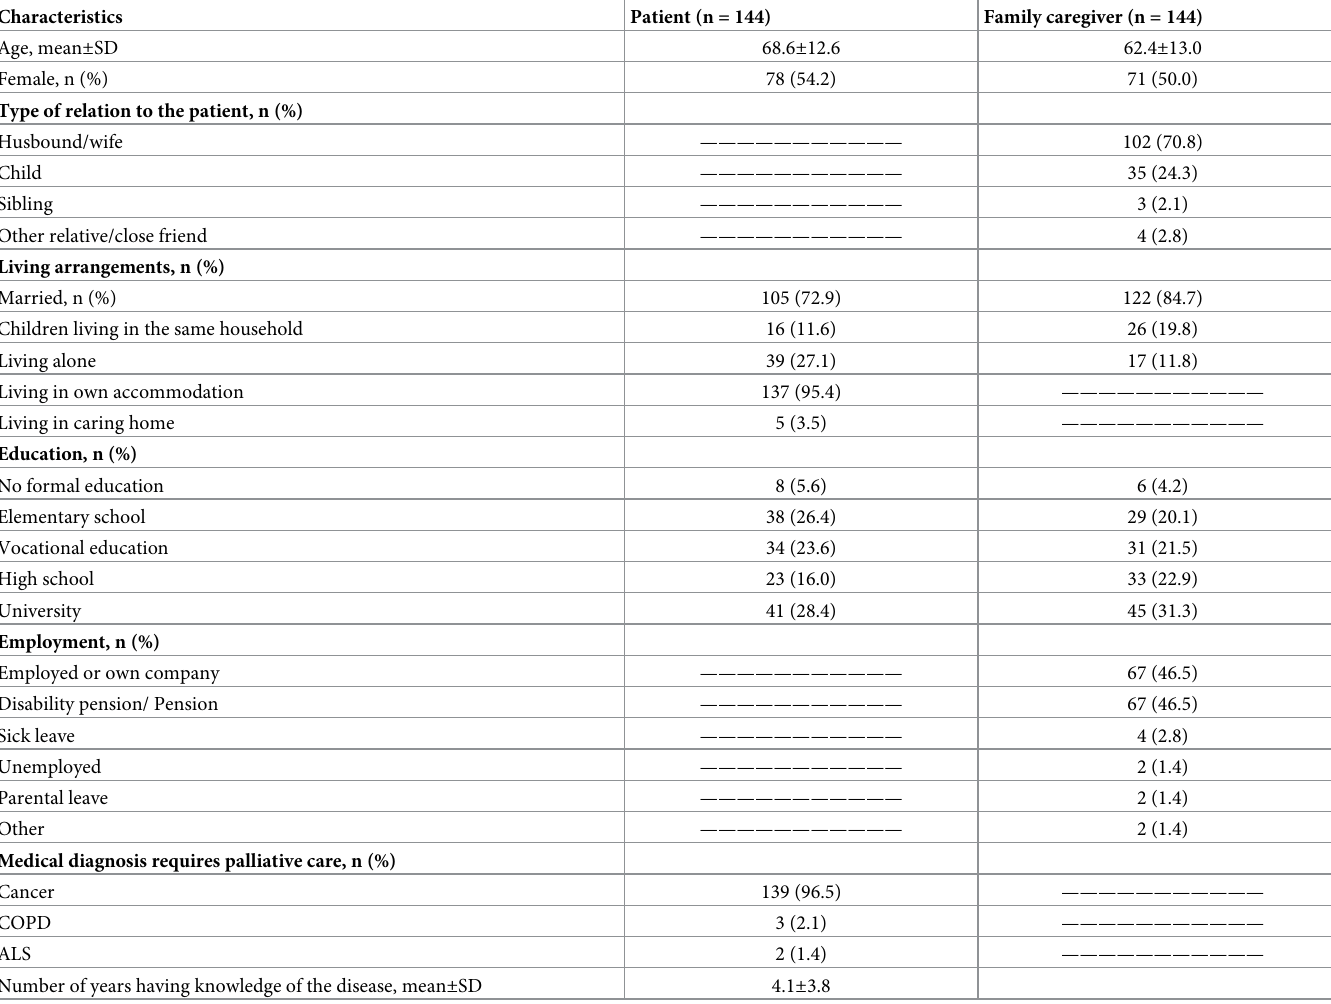
Table 2. Clinical and demographic characteristics of the dyads.